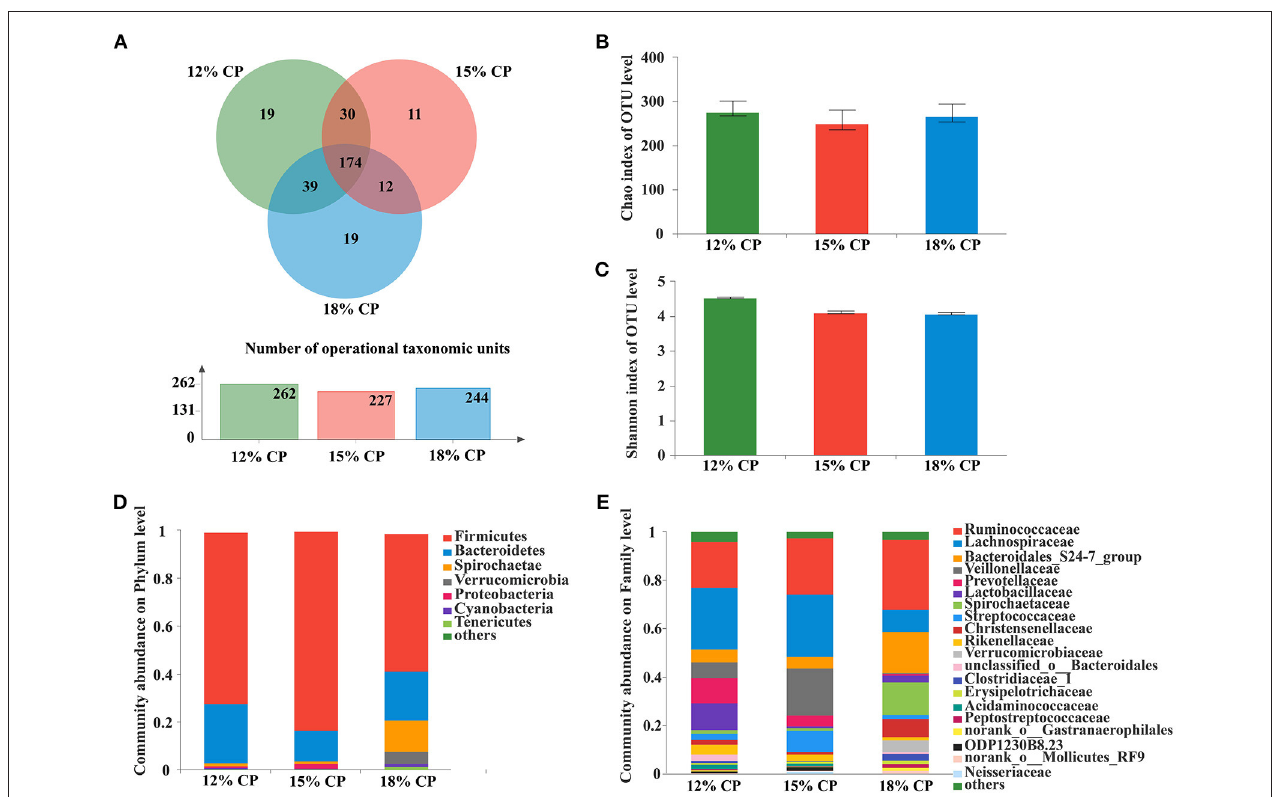
FIGURE 3 | Effects of low-protein diets on the richness and composition of colonic microbiota in growing pigs at the phylum and family levels. (A) Venn of the operational taxonomic units (OTUs) among different dietary treatments in the colon. (B) Chao index of the bacterial community in the colon. (C) Shannon index of the bacterial community in the colon. (D) Distribution of colonic bacteria at the phylum level with relative abundance higher than 1%. (E) Distribution of colonic bacteria at the family level with relative abundance higher than